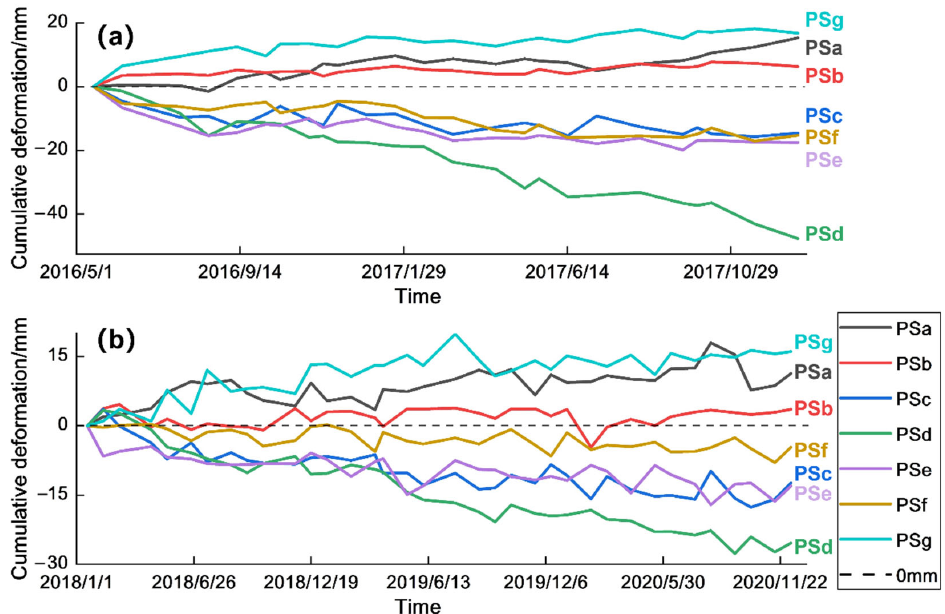
In general, the surface deformation trends in different regions of Shanghai are obvi ‐ ous, but still interspersed with nonlinear deformation, showing jagged lines in the mean cumulative deformation variogram. The above results prove that the surface deformation Figure 6. Standard deviation statistics of deformation information in the Shanghai area obtained by Figure 6. Standard deviation statistics of deformation information in the Shanghai area obtained in Shanghai is influenced by numerous different factors, which will be discussed in Sec ‐ time series InSAR technique. ( a ) Standard deviation of deformation information in 2016–2017; ( b ) by time series InSAR technique. ( a ) Standard deviation of deformation information in 2016–2017; tion 5. standard deviation of deformation information in 2018–2020. ( b ) standard deviation of deformation information in 2018–2020.